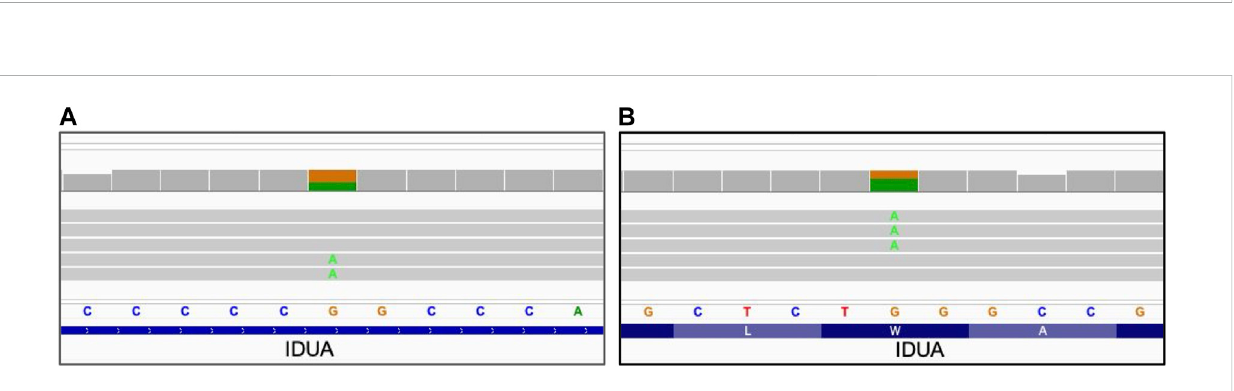
FIGURE 2 Phasing of compound heterozygous small sequence changes. Alignment view of the long read WGS of sample NA01256 with two variants in the IDUA gene. Each thick gray horizontal line represents a separate read. Top of each panel represents a local coverage depth and color coded when applicable to indicate nucleotide variability at the corresponding position. Panels A and B are continuation of each other with preserved order of reads spanningbothofthem.Indicatedvariantsarelocatedwithinthedistancespannedbythosereadsandcanbereliablyphased,con fi rmingassociation with alternative haplotypes. String of letters below the panels indicate reference nucleotide sequence, and colored nucleotides over the read sequences stand for the alternative allelic variants. (A) Single nucleotide variant IDUA_c.590-7G > A; (B) Single nucleotide variant IDUA_c.1205G >